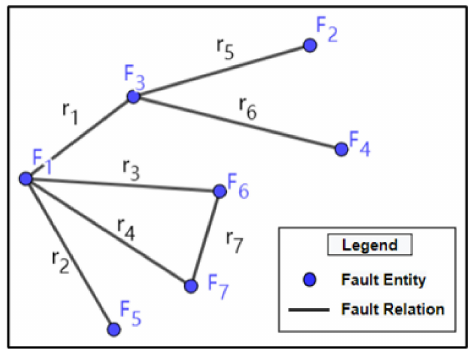
Figure 18. Graph model of complex fault